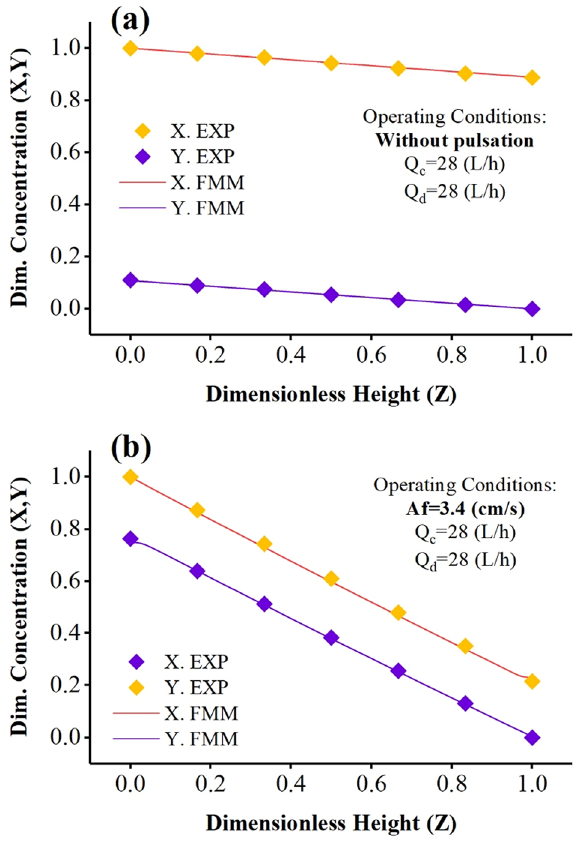
Figure 3. Comparison of laboratory concentration profiles with predicted by the forward mixing model under Q c = Q d = 28 (L/h) and ( a ) without pulsation, ( b ) Af = 3.4